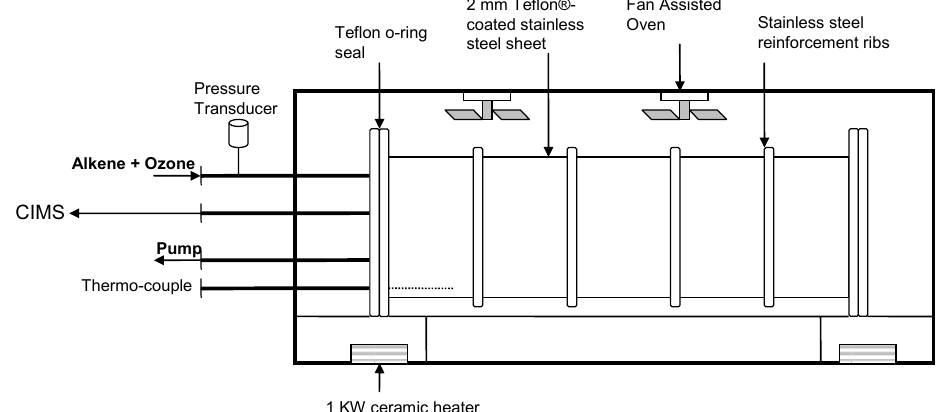
Figure 2 : A schematic diagram of the CIMS system Fig. 1. A schematic diagram of the EXTRA chamber.